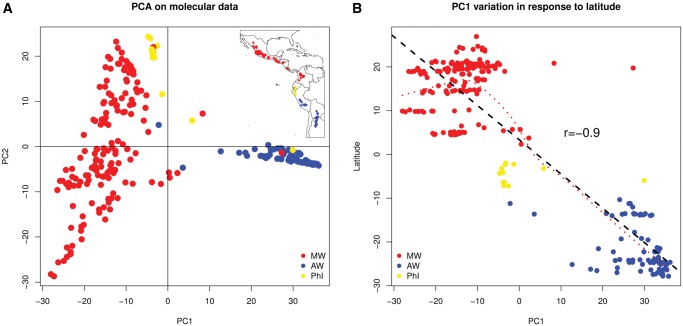
(A) Molecular PCA analysis of genetic diversity in wild Phaseolus vulgaris. Inset: Geographical distribution of the genotypes analyzed. (B) Correlation between molecular PC1 and latitude of wild P. vulgaris. Black dashed line: linear correlation; red dotted line: local polynomial regression. Pearson’s correlation coefficient (r) is shown. MW, Mesoamerican wild; AW, Andean wild; PhI, Northern Peru–Ecuador.